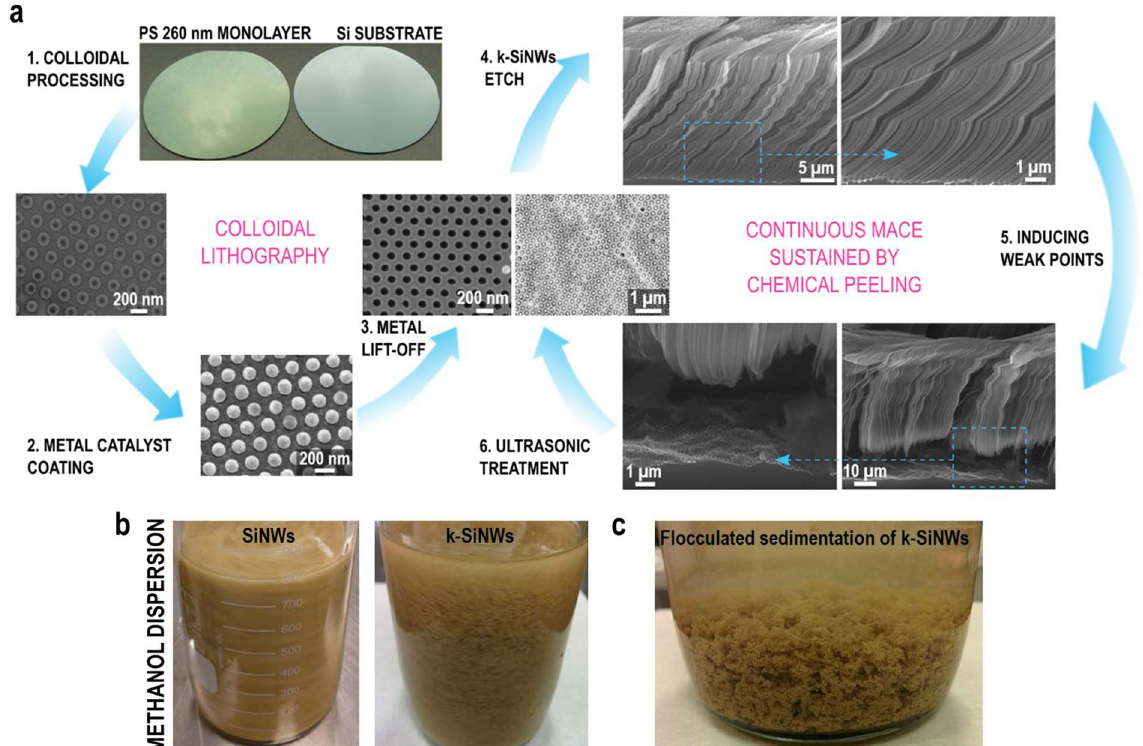
Figure 1. Kinked SiNWs synthesis and processing. Continuous synthesis of k-SiNWs sustained by chemical peeling ( a ). The first step is the nanopatterning of the metal catalyst mask, conveniently achieved by colloidal lithography with polystyrene spheres. Their diameter can be customized by reactive ion etching (1). The holey Au mask can be obtained after the coating of the patterned Si substrate with a thin film (2) and the subsequent removal of the polystyrene spheres (3). The main fabrication step involves etching in a solution containing HF and H 2 O 2 . The etching parameters are favorable for non- < 100 > etching directions. Interrupting the etching at certain points induces changes in the etching direction and triggers the formation of kinks between adjacent segments (4). When the desired length is achieved, the etching conditions are again modified to favor the presence of a porous segment at the base of the k-SiNWs (5). This porous segment facilitates the separation of k-SiNWs from their Si substrate with a short ultrasonic treatment, leaving the metallic mask intact and ready for a new etching sequence (6). Dispersion of SiNWs vs. k-SiNWs in methanol ( b ). Optical image of the flocculated sedimentation of k-SiNWs ( c